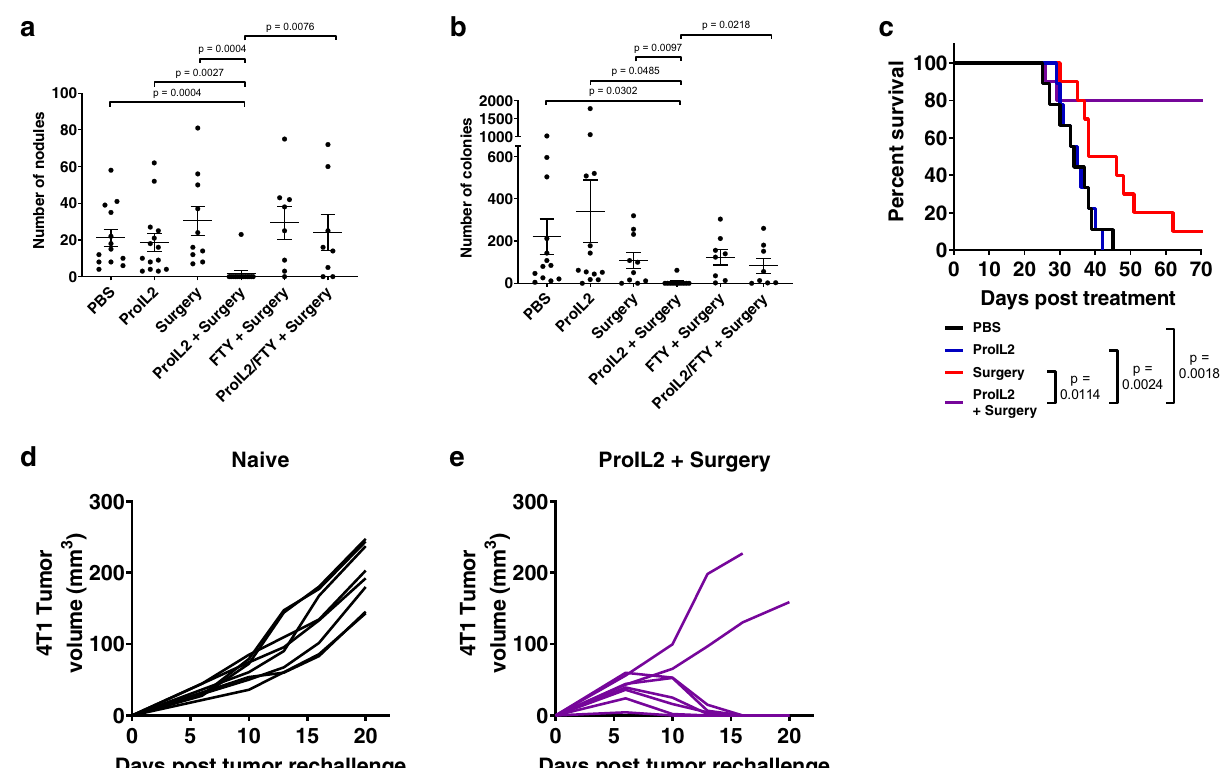
Fig. 7 Preoperative ProIL2 combined with surgery can eliminate metastases through an abscopal effect. 4T1 s.c. tumor-bearing mice were injected i.p. with PBS or ProIL2 (300 pmol) on days 9 and 12 post tumor inoculation. Mice treated with FTY720 were i.p. treated with 10 μ g every other day for 14 days starting on day 8 post tumor inoculation. On day 14 post tumor inoculation, the listed mice had their tumors surgically removed. a 25 days post initial treatment, mice were euthanized and metastatic nodules in the thoracic cavity were counted. b 25 days post initial treatment, mice were euthanized and lungs were extracted, digested in collagenase/DNAse, and resuspended as single cells. Resuspended cells were plated at a 1:400 ratio with 6-thioguanine selection medium, and the number of colonies were counted 6 days post seeding ( n = 3 experiments, total 13 individual mice for PBS treatment group, 10 for Surgery, 14 for ProIL2 and ProIL2/Surgery, 8 for FTY/Surgery and FTY/ProIL2/Surgery). c Mice were analyzed for survival starting the day after the fi rst i.p. injection treatment ( n = 2 experiments, total 9 individual mice for PBS and ProIL2 treatment groups, 10 for Surgery and ProIL2/Surgery). Data represent mean ± s.e.m. Student ’ s t tests ( a , b ) and log-rank tests ( c ) were performed to calculate p values. d , e Either naive BALB/c mice or ProIL2/surgery cured mice were rechallenged with s.c. 4T1 tumors in the opposite fl ank of primary tumor injection. Tumor growth was measured and displayed as individual curves ( n = 2 experiments, total 8 individual mice per group). Source data are provided as a Source Data fi